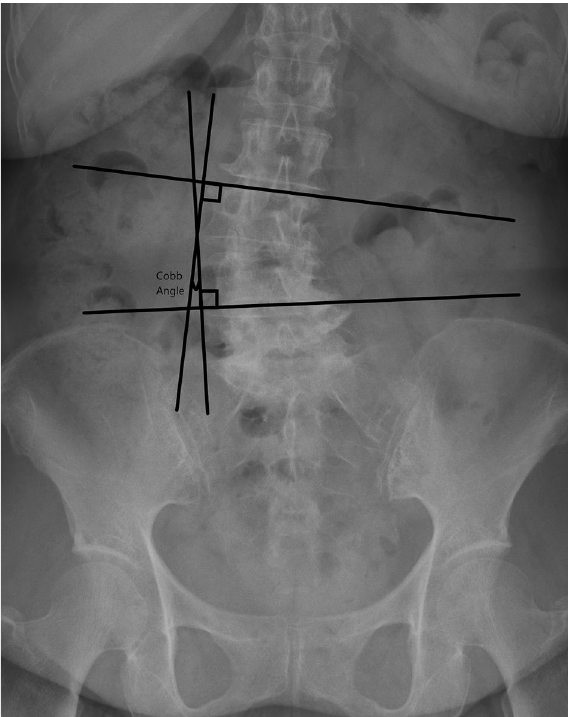
Figure 4. The measurement of coronal tilting angle was assessed by measuring the Cobb angle of superior endplate line of upper vertebral body and the lower endplate of lower vertebral body on lumbar antero-posterior view image.